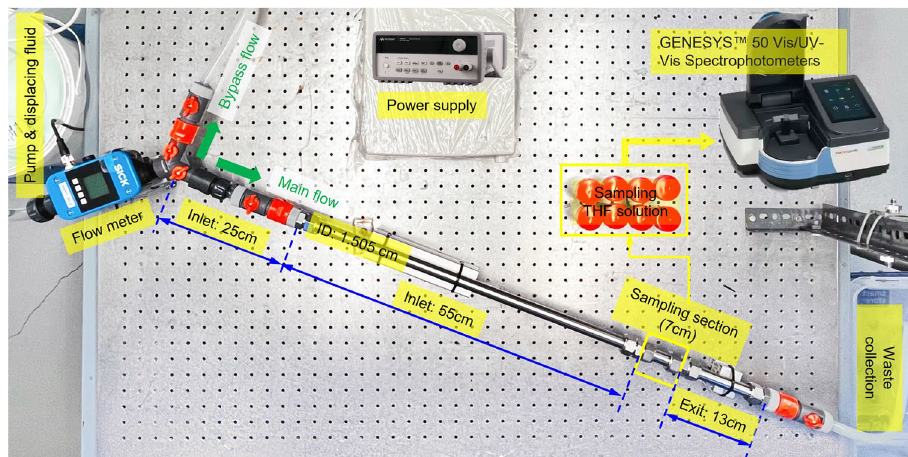
Figure 1. Layout of the experimental